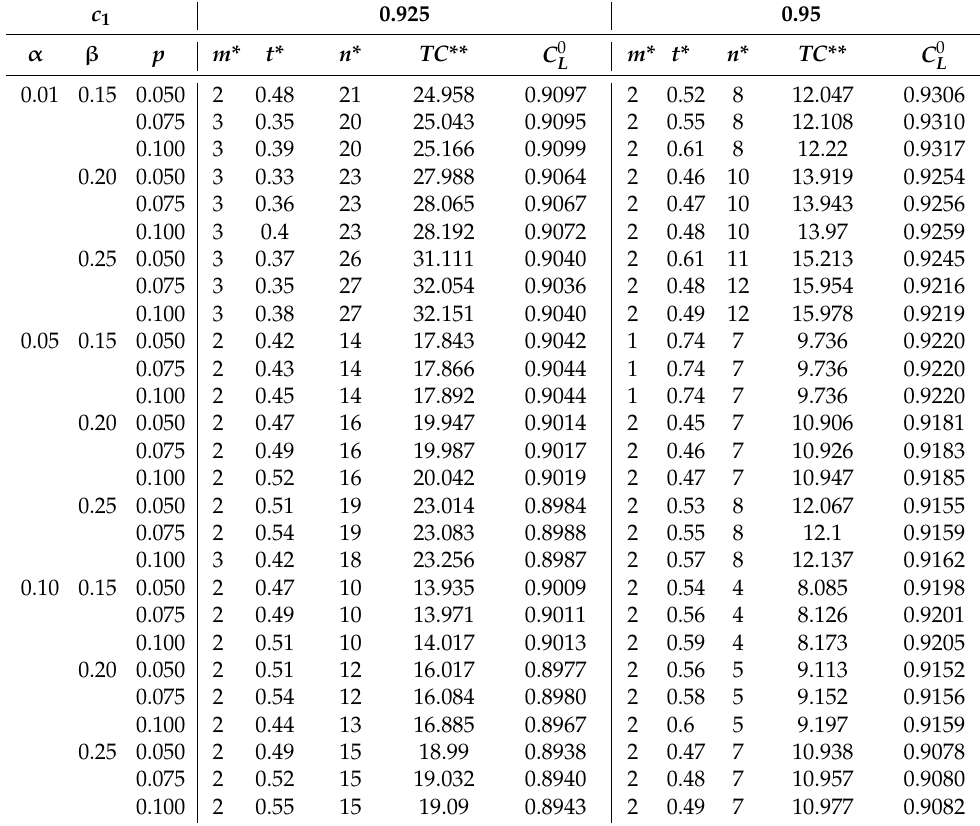
Table 4. The optimal ( m *, t *, n *), total cost TC and critical value for c 1 = 0.925, 0.95, α = 0.01, 0.05, 0.1, β = 0.25, 0.20, 0.15 and p = 0.05, 0.075, 0.1 under m 0 = 20, L = 0.05 and c 0 =